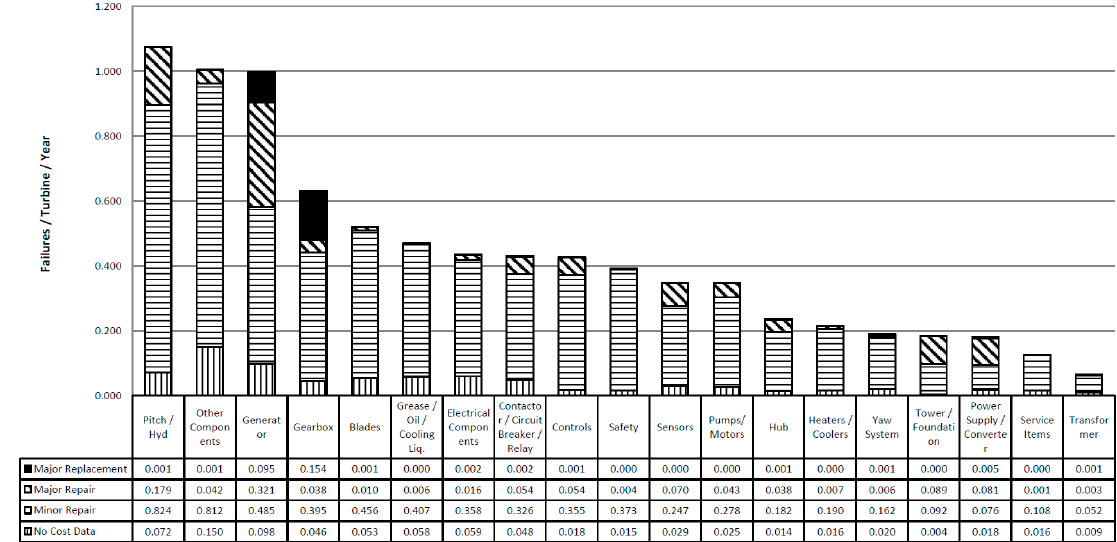
Figure 1. Failure frequency of offshore wind turbine components categorized by their maintenance effort [40].